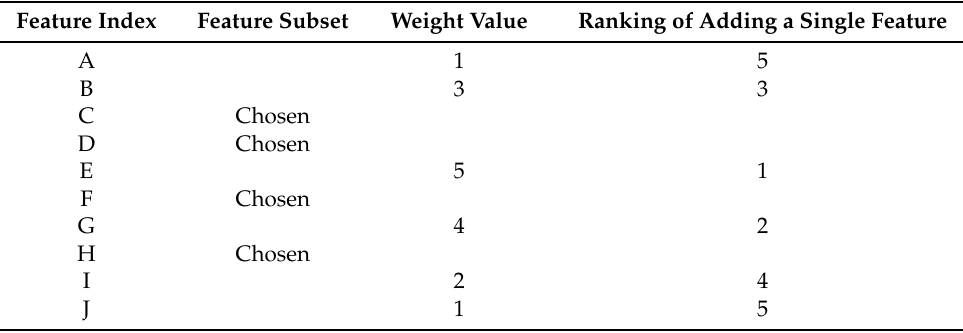
Table 1. Weight value and ranking of unselected features of Figure 5.